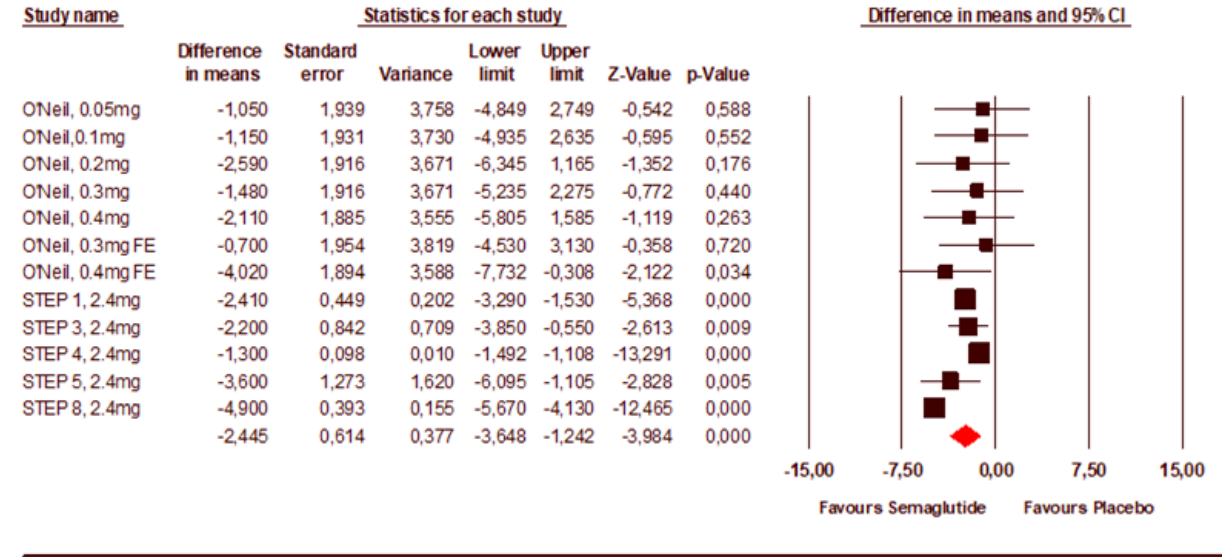
Figure 3. Forest plot of semaglutide vs. placebo showing the pooled weighted mean difference for DBP (random effects model).